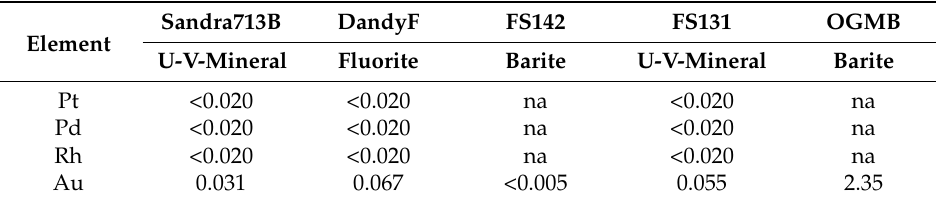
Table A1. PGM and Au Results American Analytical Services (AAS) laboratory. Sandra713B DandyF FS142 Element